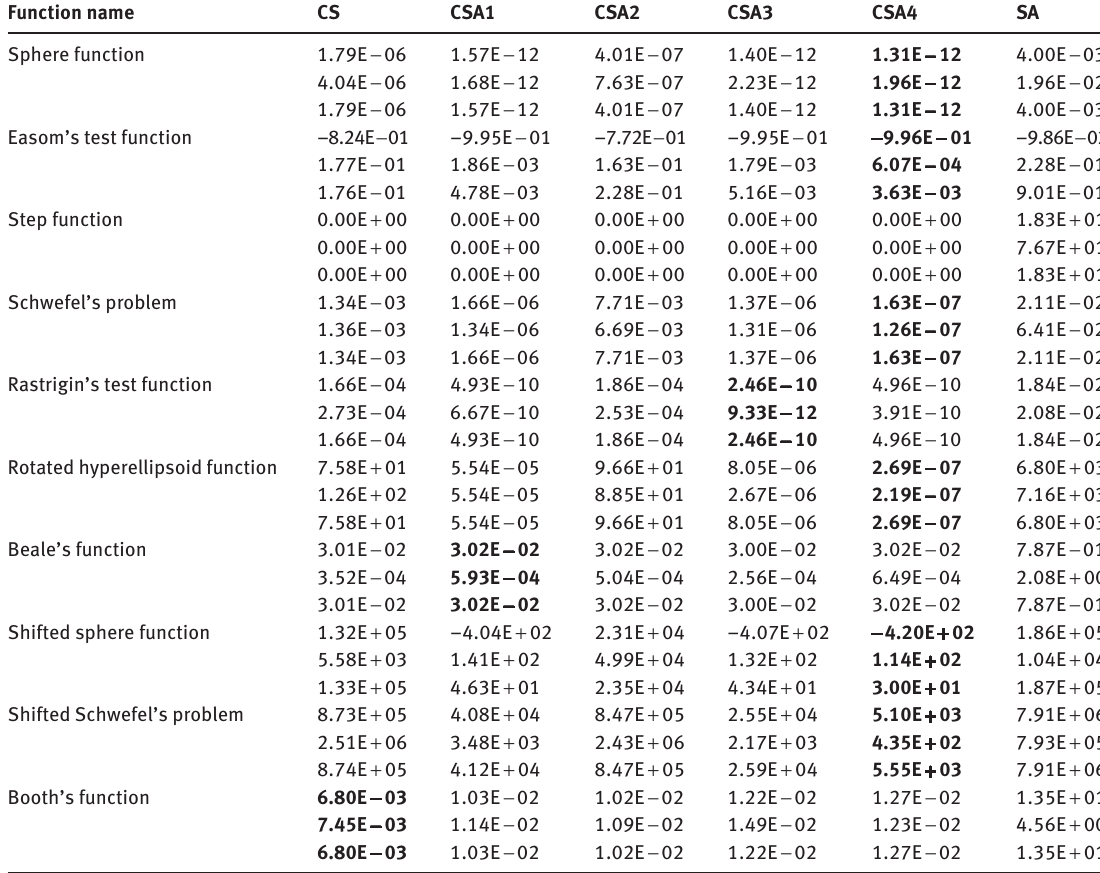
Table 3: Experimental Results of the Algorithms for each of the 10 Benchmark Functions. Function name CS CSA1